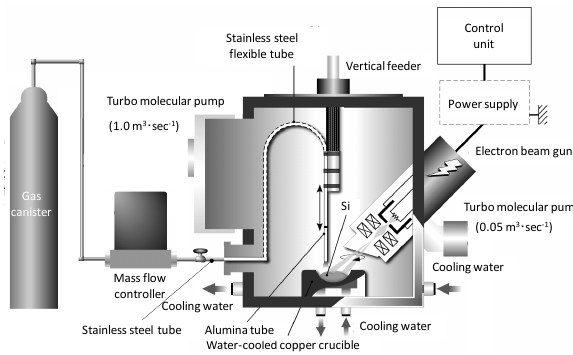
Figure 1. Electron beam melting apparatus with gas sup- plying